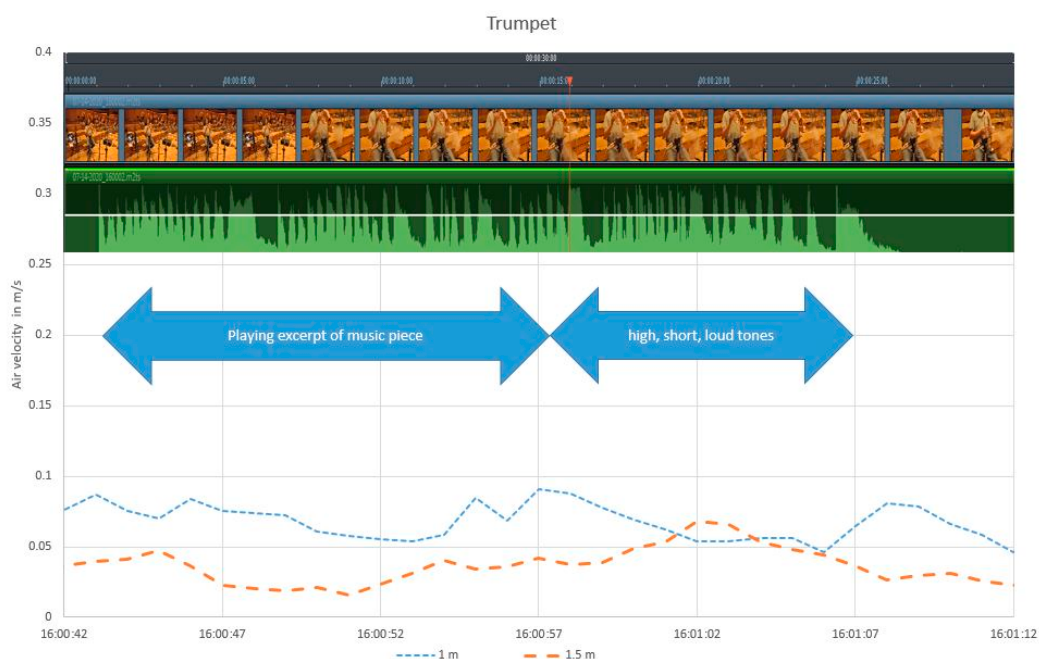
Figure A7. Example measurements 2 (trumpet): playing and pitches. Note: This is an example of the measurements (trumpet). At the top, screenshots from the qualitative videos can be seen and the acoustics are shown. The graphic shows that there are no differences in the measurements of airflows between playing excerpts of a music piece or short high pitches. At 2 m no more airflows were measurable; therefore, the 2 m line is irrelevant and not included in the graphic.